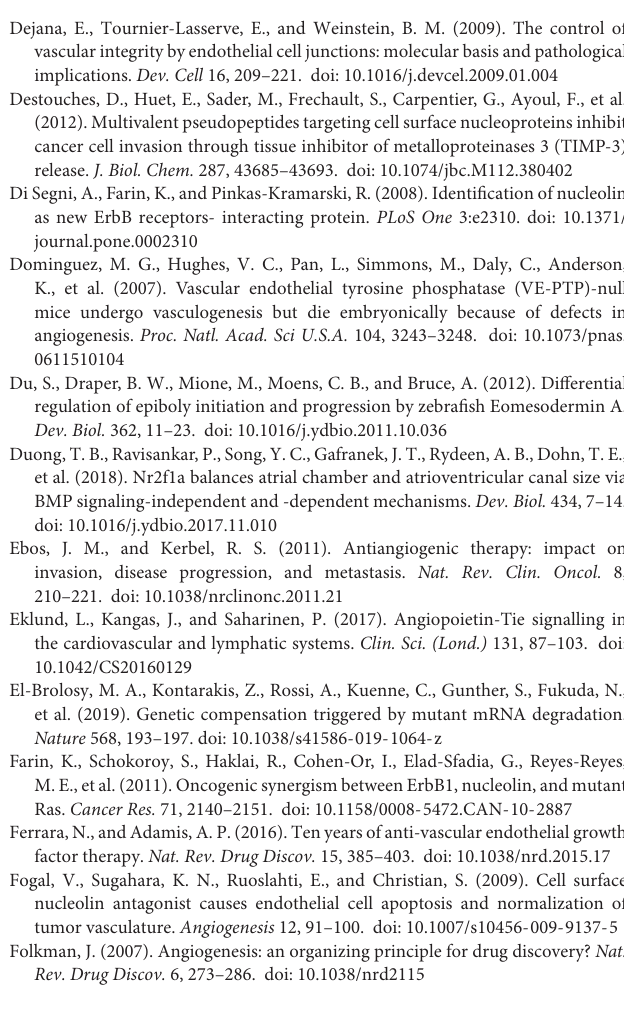
The video showed the heart beat in splice-blocking and ATG morpholino group, respectively, with comparison to control group.